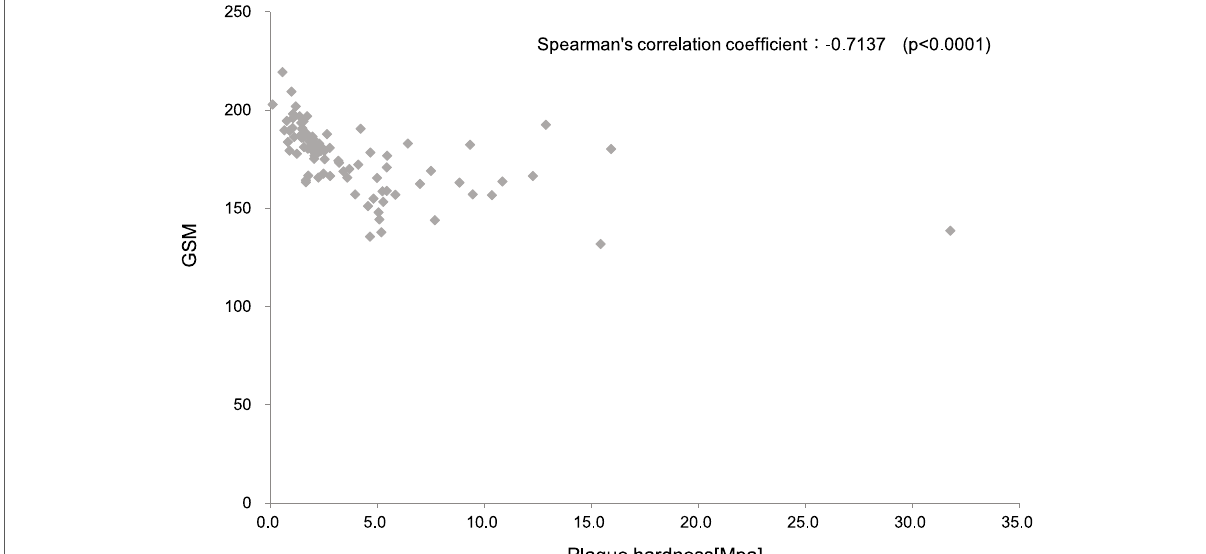
Fig. 4 Plaque hardness was negatively correlated with GSM from EVG [Spearman’s correlation coefficient: -0.7137 ( p < 0.0001)], indicating that hard plaques are rich in